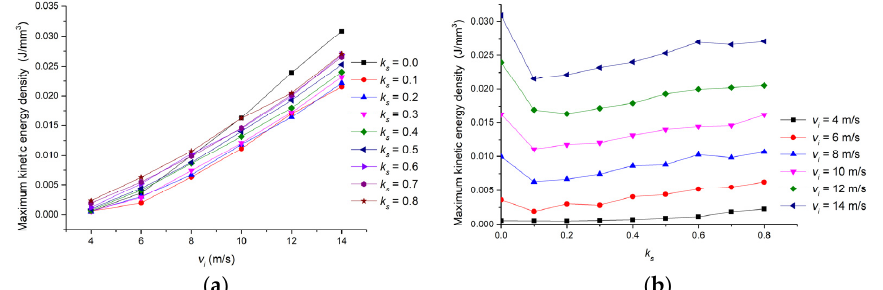
Figure 7. The maximum kinetic energy per unit volume of coal specimens subjected to different pre- stress levels and impact speeds. ( a ) The curves of v i vs maximum kinetic energy per unit volume; ( b ) The curves of k s vs maximum kinetic energy per unit volume.